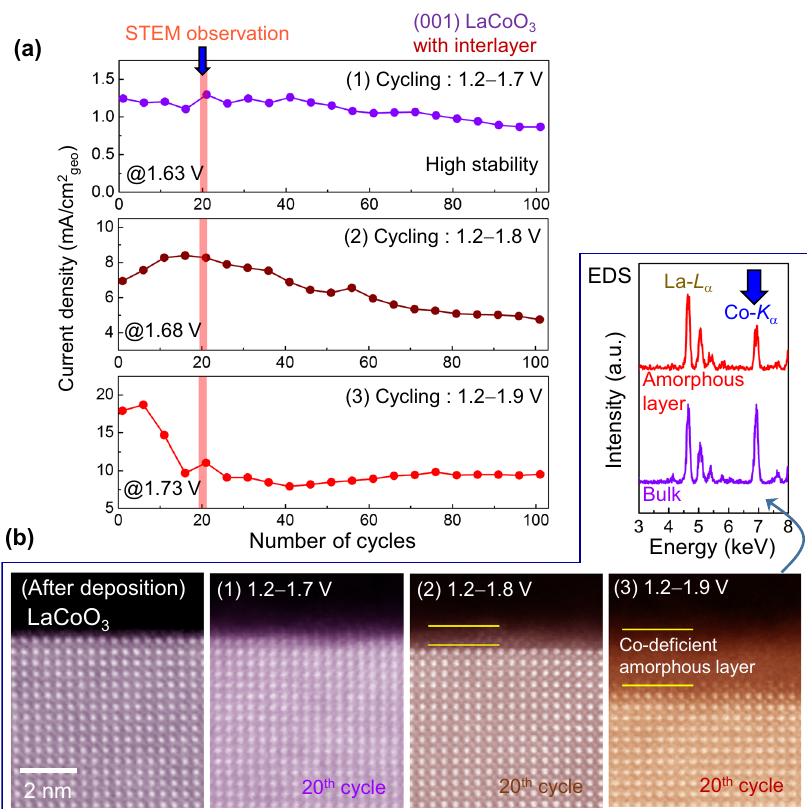
Fig. 7 Durability of OER activity in LaCoO 3 thin fi lms. a A set of three plots for the current-density variation with anodic cycling is provided. If the potential range is adjusted so as not to exceed 1.7 V vs. RHE, the high OER current density of LaCoO 3 is preserved even after 100 anodic cycles, demonstrating notable durability of the high activity. b A series of STEM images show the surface variations with different potential ranges during cycling. In addition to the image of a pristine fi lm, each images was acquired after the 20th cycle, as indicated in red shadows in a . The formation of an amorphous layer is indicated by a pair of yellow lines in each image. As compared in the EDS spectra, this amorphization is induced by Co dissolution at high